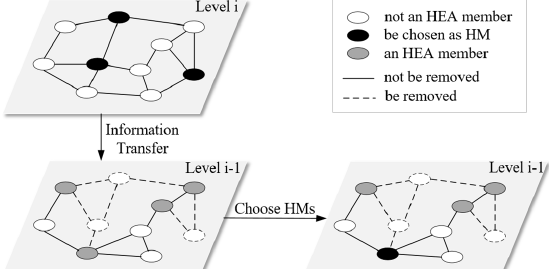
Figure 2. An example operation in inter-layer information transfer (IIT)-DOWN. Nodes do not change in different layers, but the connections among them may be different. Nodes in black are chosen for the placement of name-resolution servers. Nodes in white represent those that have not been partitioned. The HMs chosen from level i are removed in level i − 1, and grey nodes represent nodes that satisfy the latency constraint from these HMs. There are four HMs in total in this example.